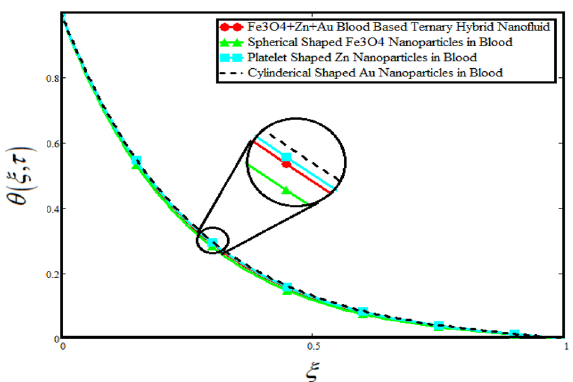
Figure 4. Comparison of temperature distribution with ternary hybrid nanofluids and unitary nanofluid when α = 0.5 , τ = 1 , Pr = 21 and Re = 1.2 .